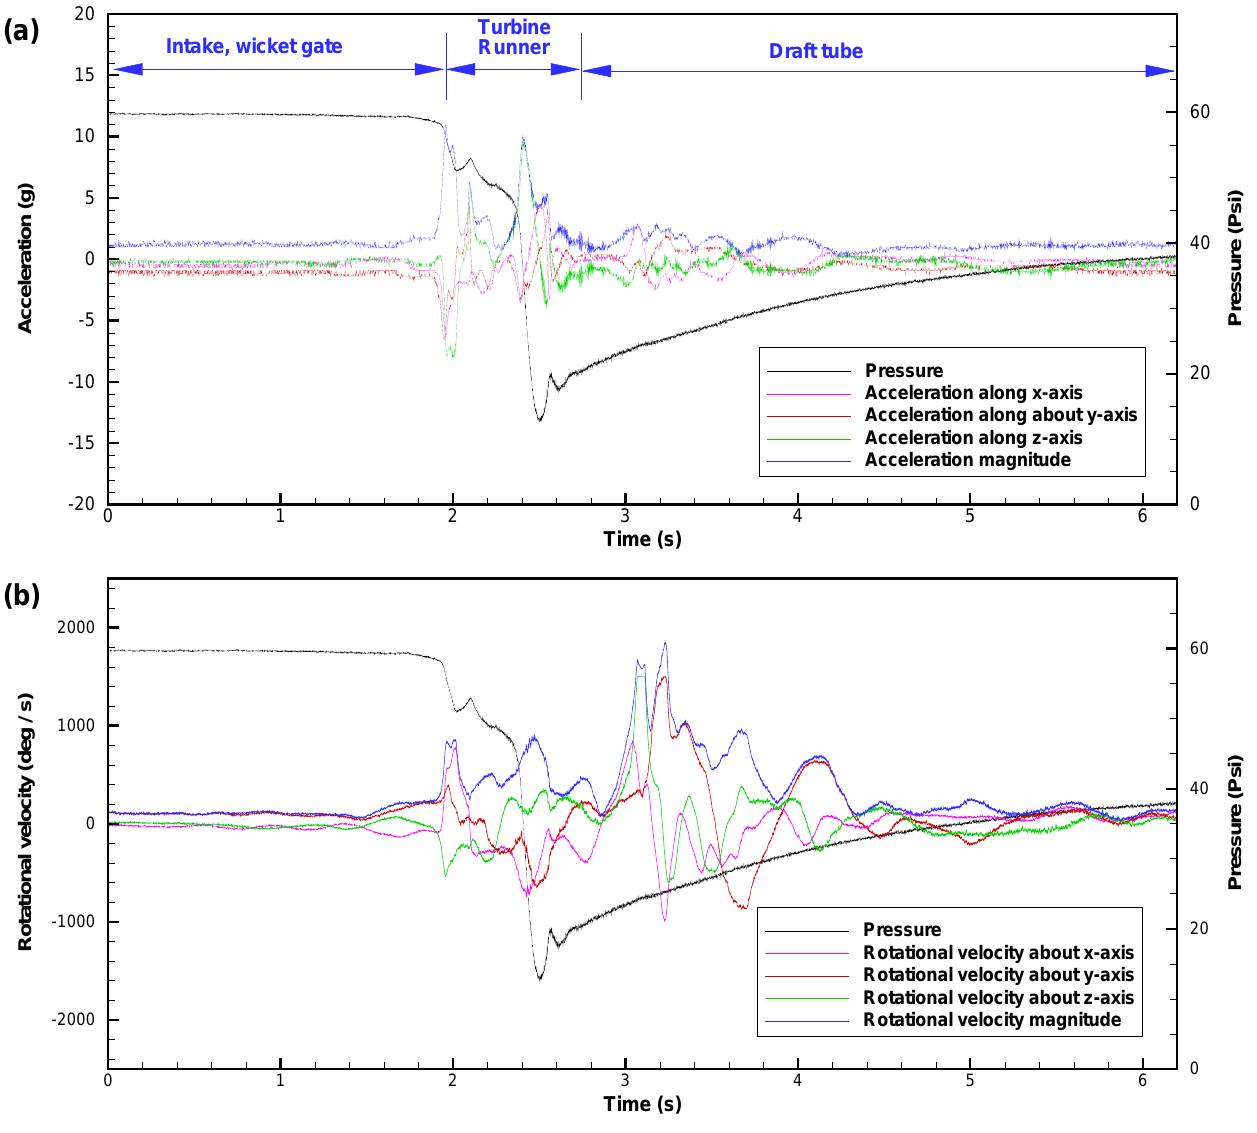
Figure 10 . An example of measurements by Sensor Fish released from the intake of Turbine Unit 9 of the John Day Dam: (a) acceleration; (b) rotational